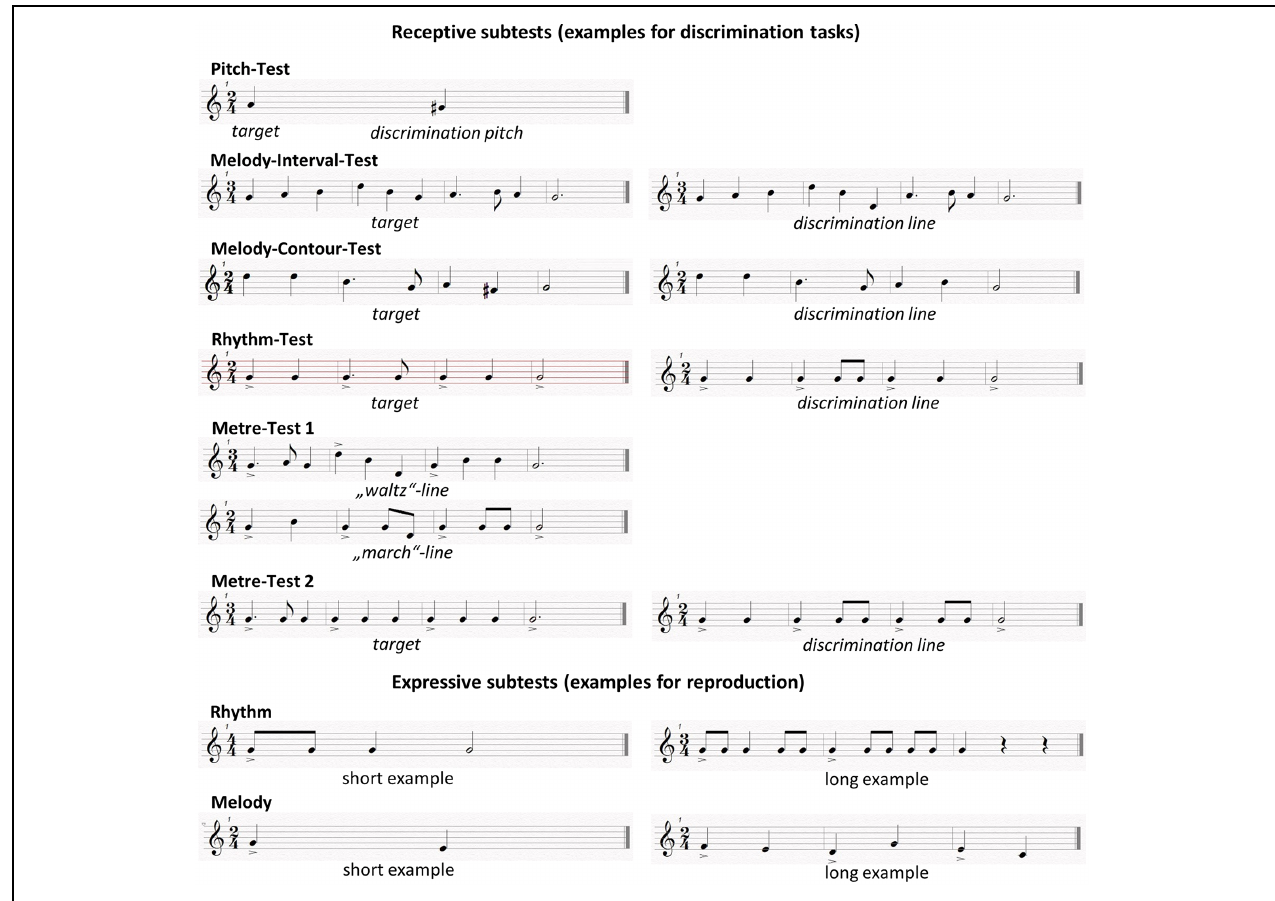
FIGURE 1 | Examples of receptive and expressive